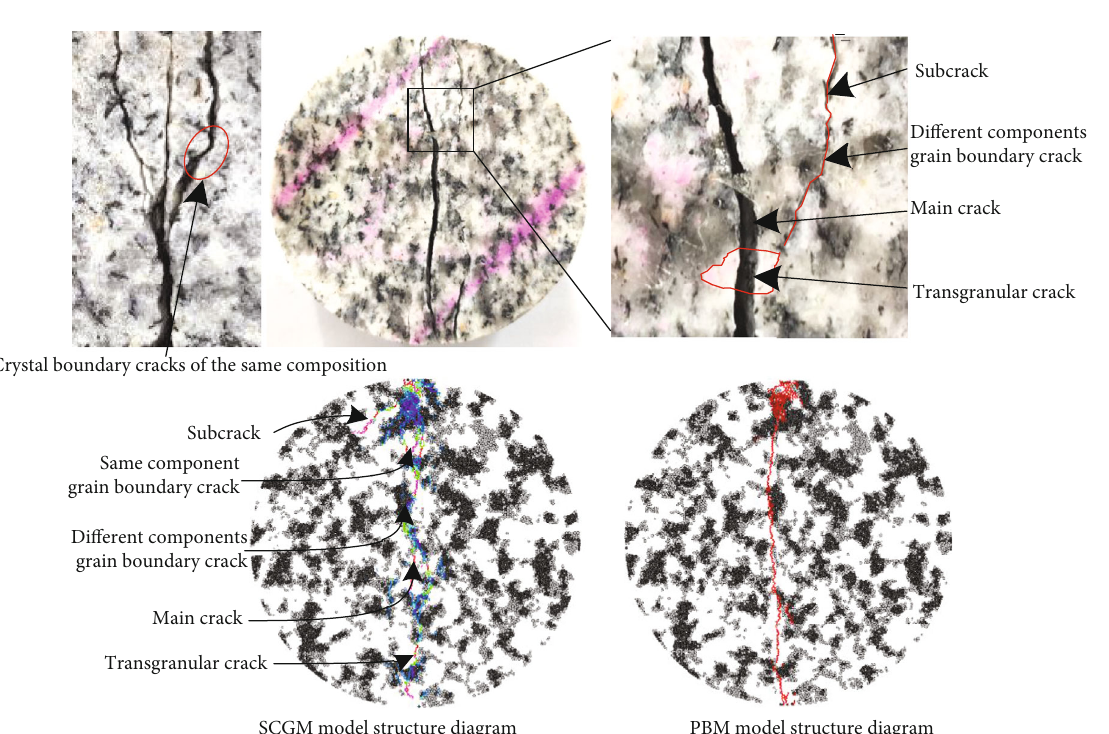
Figure 10: Brazil split test results of SCGM and PBM models.